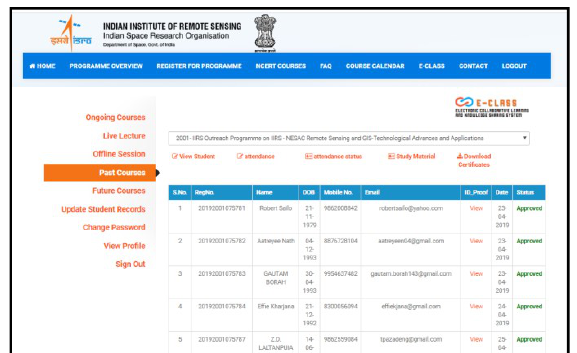
Figure 1. IIRS Elearning portal for the specific course showing details of all online registered candidates.